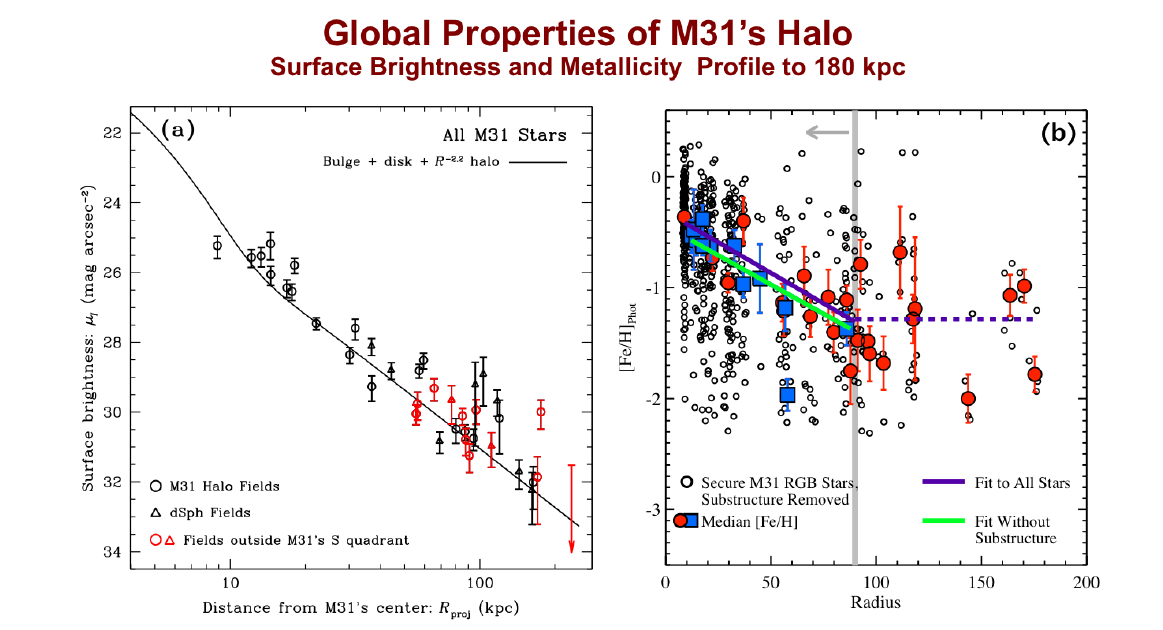
Figure 3. ( a ) The surface brightness profile of M31’s stellar halo from the SPLASH survey (Figure 6 of Gilbert et al. [27]). The number of spectroscopically confirmed M31 RGB and Milky Way (MW) dwarf stars is used to determine the surface brightness in each SPLASH spectroscopic field. The surface brightness profile of halo stars after tidal debris features have been removed follows an r − 2.2 power law to large distances from M31’s center. ( b ) Metallicity profile of M31’s stellar halo from the SPLASH survey (Figure 10 of Gilbert et al. [36]). Metallicity estimates are based on comparing the position of the star in the color magnitude diagram to a grid of isochrones at the distance of M31. All spectroscopically confirmed M31 RGB stars that are not associated with tidal debris features are shown as small, open black points; the median metallicity and estimated uncertainty in the median value are shown as large, solid red circles (fields without tidal debris features) and blue squares (fields with tidal debris features). No tidal debris features are identified in fields greater than 90 kpc from the center of M31, in which the samples of M31 stars are small. M31’s halo shows a significant gradient with metallicity to at least 100 kpc. The solid lines show fits to the median metallicity in fields out to 90 kpc, while the dashed line shows the median metallicity of stars in fields at projected distances > 90 kpc from M31’s